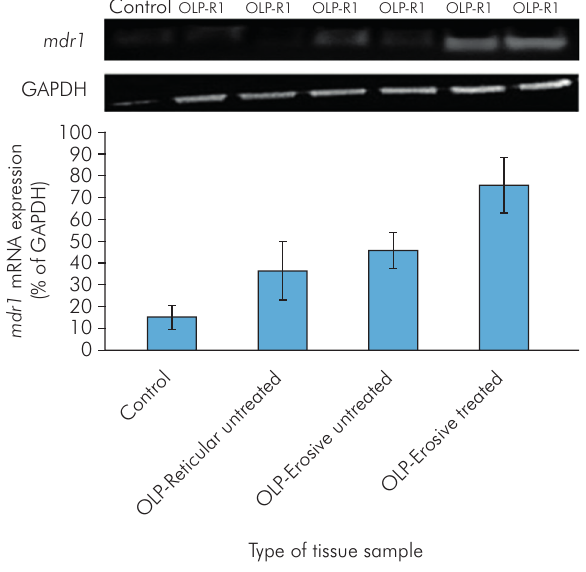
Figure 2. The upper panel shows the expression of mdr1 mRNA through SQ-RTPCR. The analysis shows that expression levels are significantly higher (p < 0.0001) in any OLP tissue compared to the healthy group. The untreated erosive group shows significantly higher (p < 0.05) expression of mdr1 compared to untreated reticular group, and treated erosive group patients had elevated (p < 0.0001) expression of mdr1 was compared to the untreated group. (OLP-R: Oral lichen planus reticular type; OLP-E: Oral lichen planus erosive type; OLP-ET: Oral lichen planus erosive - treated).